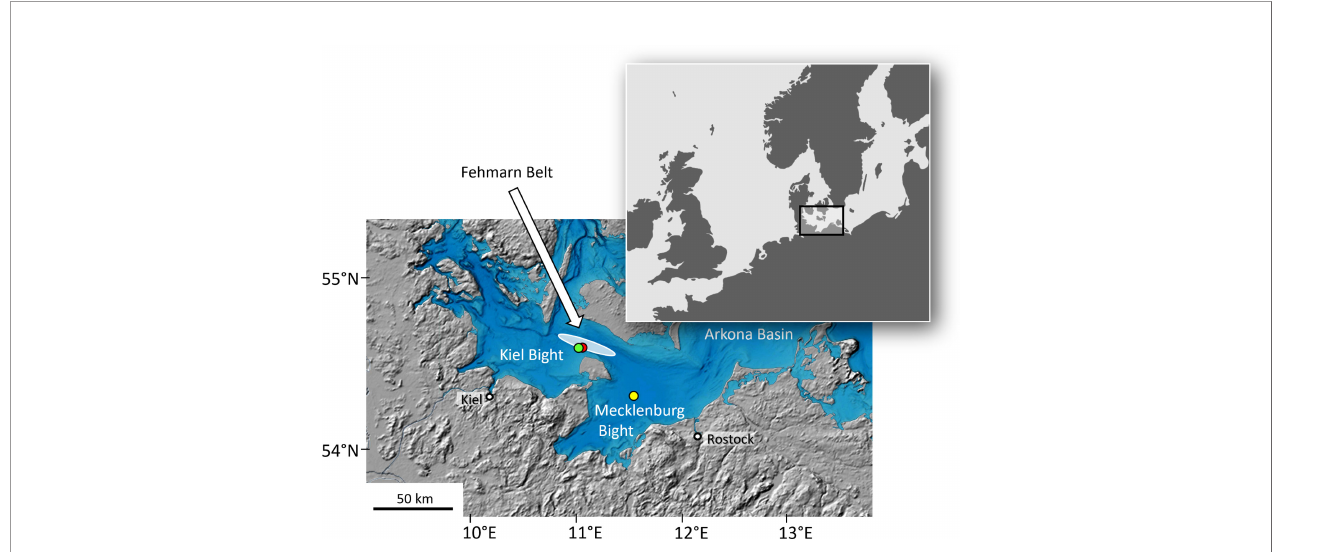
FIGURE 1 | Map showing sample localities in the Bay of Mecklenburg (yellow circle: St12, 54°18 ′ 59.50 ′′ N, 011°33 ′ 00.00 ′′ E, 25 m water depth) and Fehmarn Belt (green circle: FBR36, 54°35 ’ 52.80 ” N, 010°51 ’ 28.80 ” E, 21 m; red circle: FBR06, 54°37 ’ 01.20 ” N, 011°00 ’ 36.00 ” E, 18 m). White oval denotes area where instrumental records came from. Map sources: inlet (upper right) modi fi ed after http://www.mygeo.info; bathymetry map modi fi ed after http://data.bshc.pro (Baltic Sea Bathymetry Database); last access: 27 Oct. 2021.